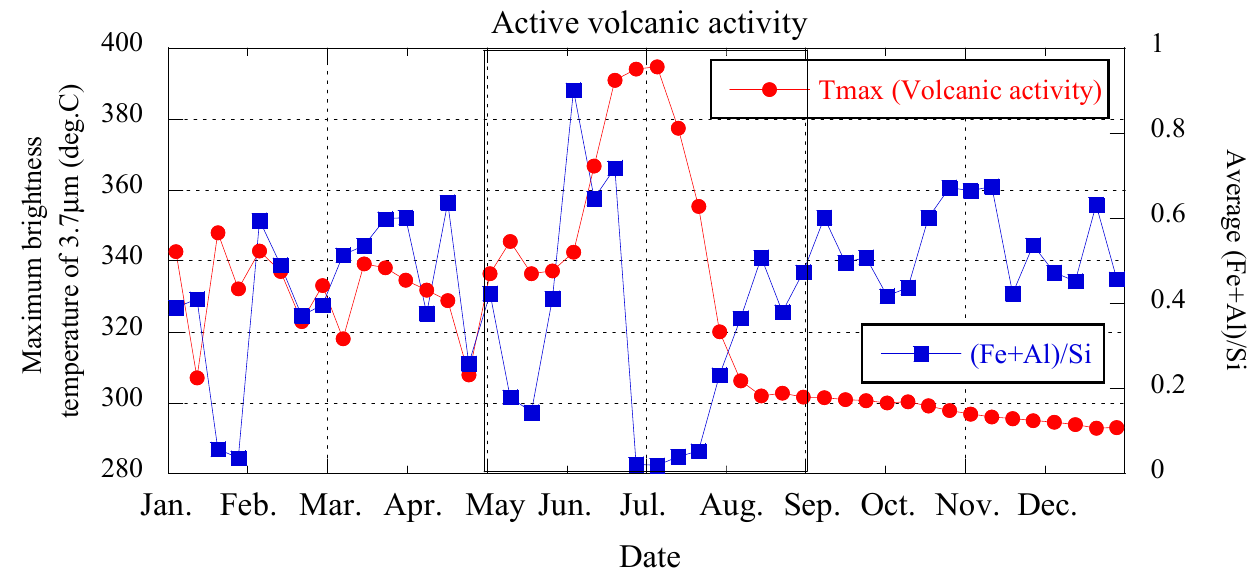
Figure 8. Comparison of the time series between Tmax (as a volcanic activity from Himawari-8) and an area average (Fe + Al)/Si of the discolored seawater color around Nishinoshima Island (from GCOM-C) during 2020. (Both datasets involved an 8 day